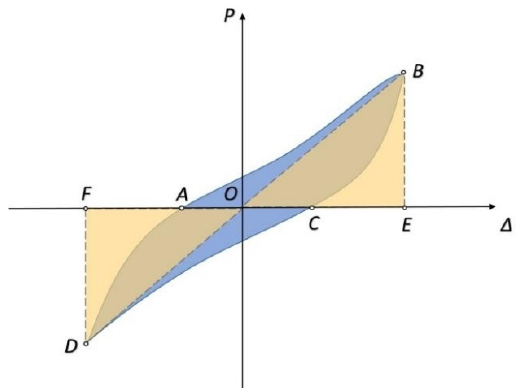
Figure 18. Energy dissipation coefficient of FW-1 and FW-2.